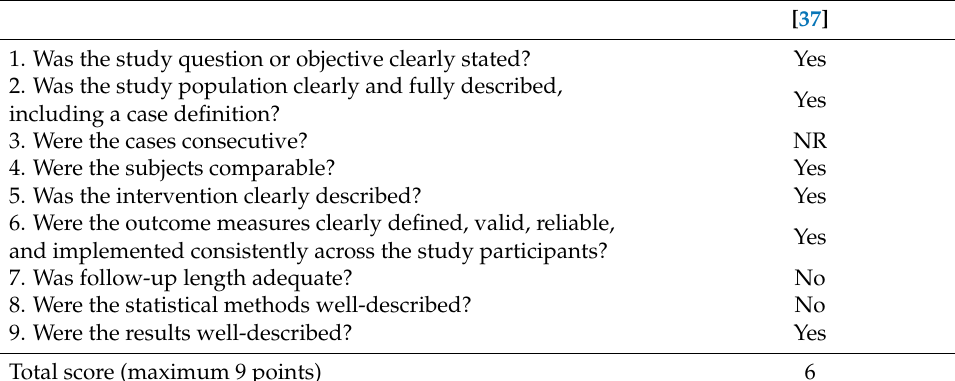
Table A4. Quality assessment of Case Studies